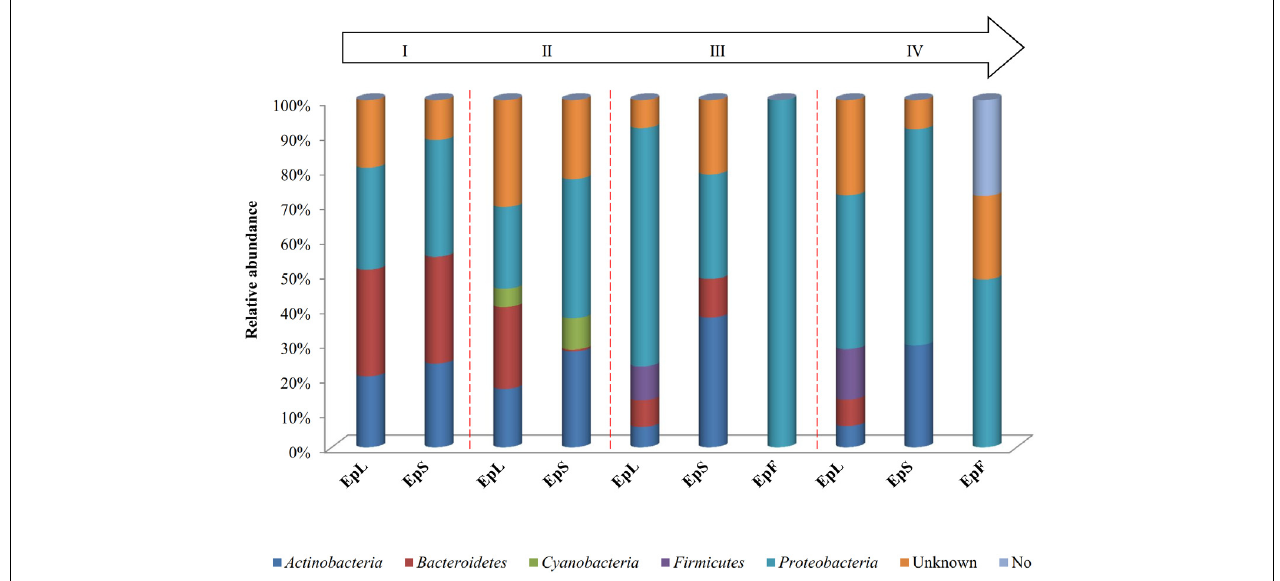
FIGURE 2 | Relative abundance of bacterial phyla in DNA samples directly extracted from epiphytic (Ep) fraction of leaves (L), stems (S), and flowers (F) of Origanum vulgare L. plant during the early vegetative (I), late vegetative (II), blooming (III), and full flowering (IV)